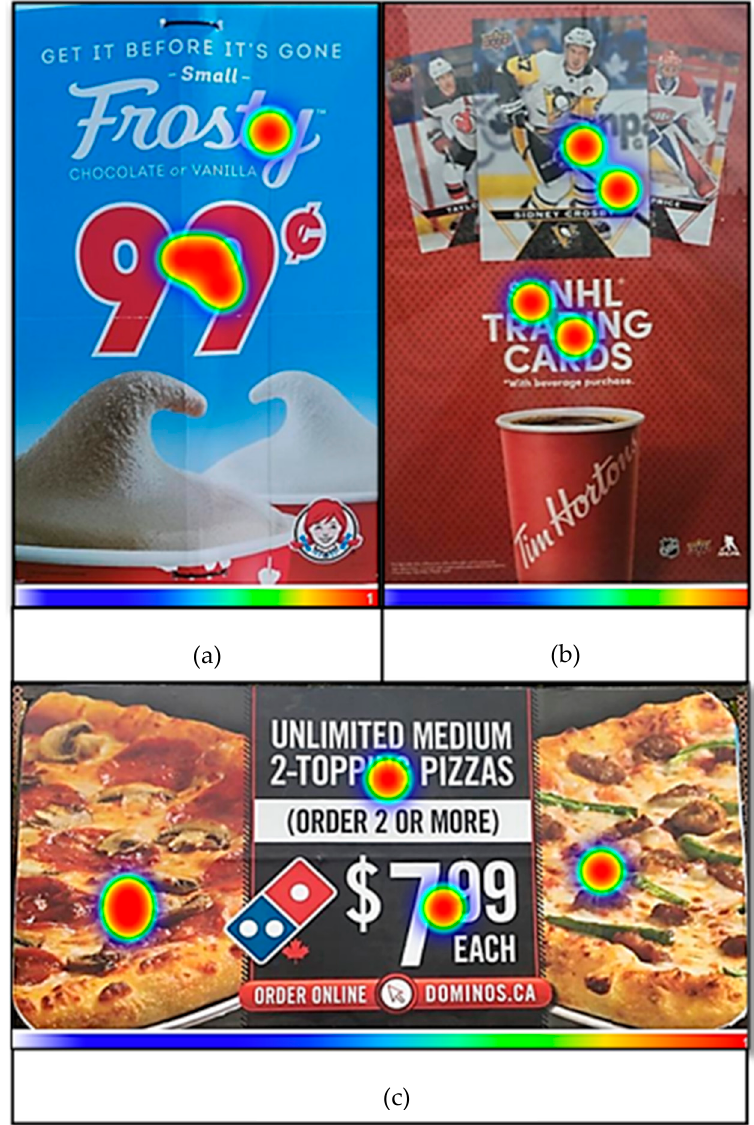
Figure 1. Teen-generated hot spots on vendor signage ( a ), transit shelters ( b ), and billboards ( c ).